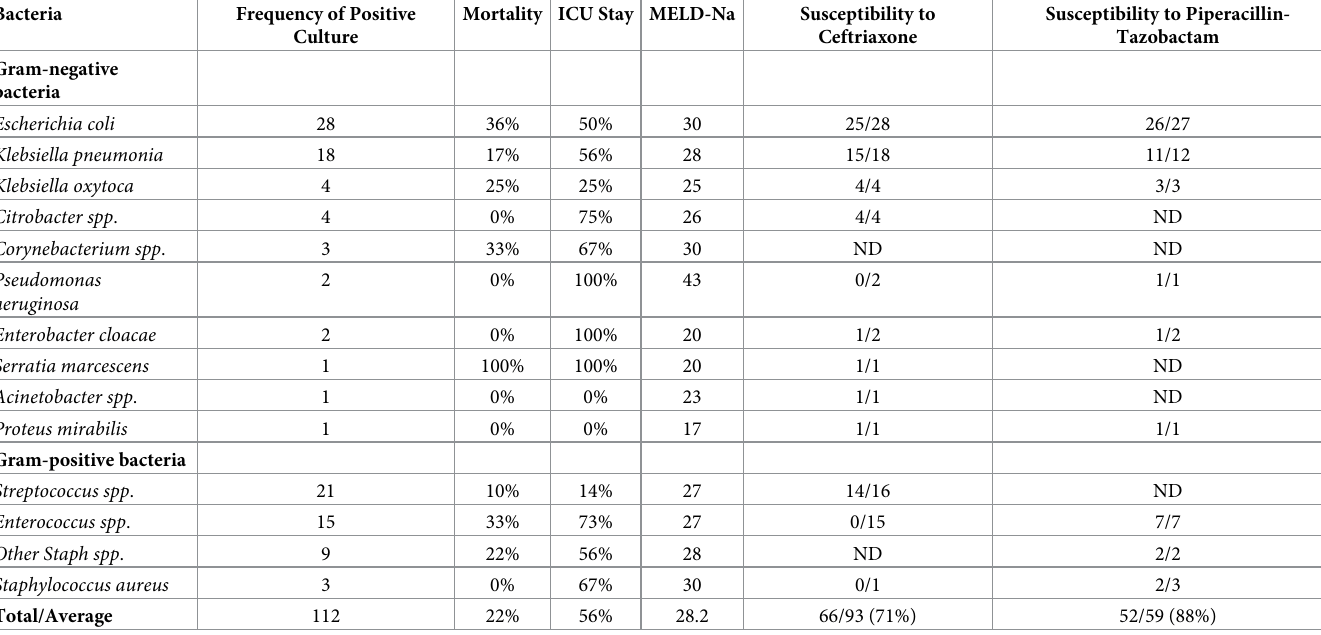
Table 2. Details on positive culture including bacteria, mortality and susceptibility to ceftriaxone or piperacillin-tazobactam.